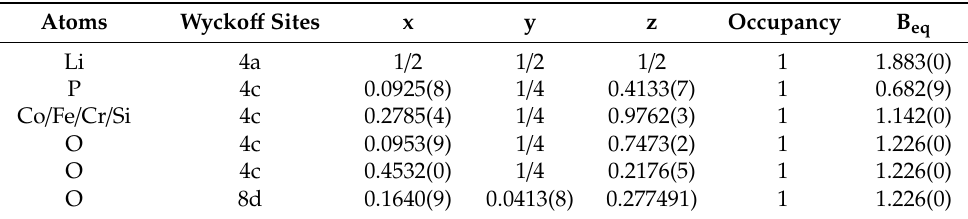
Figure 2. Measured and refined XRD patterns of the as-made Cr/Si-LCFP electrode. Blue = observed; red = calculated; grey = difference; magenta = LCFP; turquoise = Al; green/* = Li 9 Cr 3 (PO 4 ) 2 (P 2 O 7 ) 3 . Table 1. Refined crystal structure parameters.